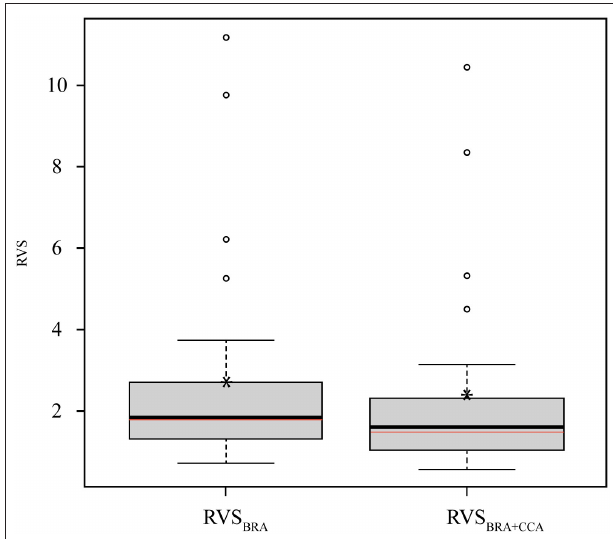
FIGURE 4 | Box-whisker plot representation of the Relative Vulnerability Scores (RVS) of native salmonid species and populations in Turkey. RVSs were calculated for two kinds of overall risk score (ORS), i.e., Basic Risk Assessment (BRA)-based ORS (RVS BRA ) and Climate Change Assessment (CCA)-based ORS (RVS BRA + CCA ). Boxes extend from the 25th to the 75th percentile of each RVS’s distribution of values; whiskers above and below the box indicate the 90th and 10th percentiles, respectively. Circles indicate the outliers (scores outside 1.5 times the interquartile range). horizontal black lines within the boxes denote median, asterisks denote the mean of the values. Horizontal red lines within the boxes denote the mean RVSs calculated by excluding the